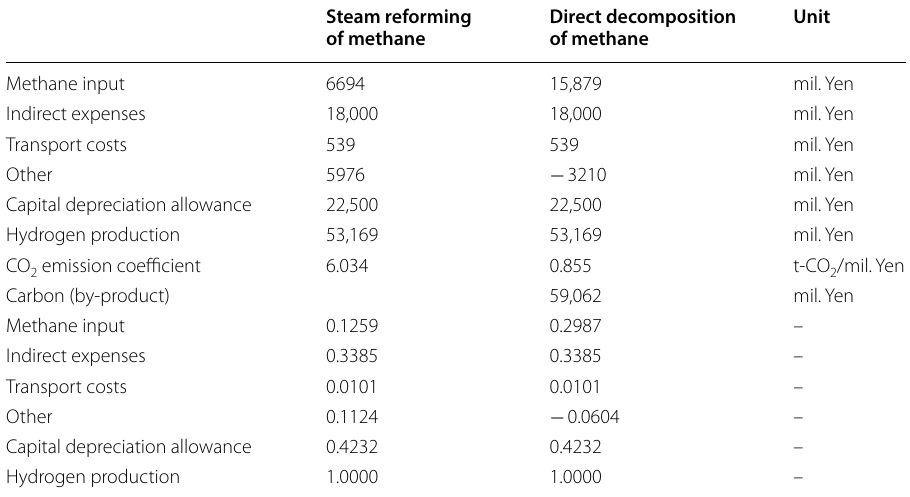
Table 9 Input structure of hydrogen production (by technology). Source :